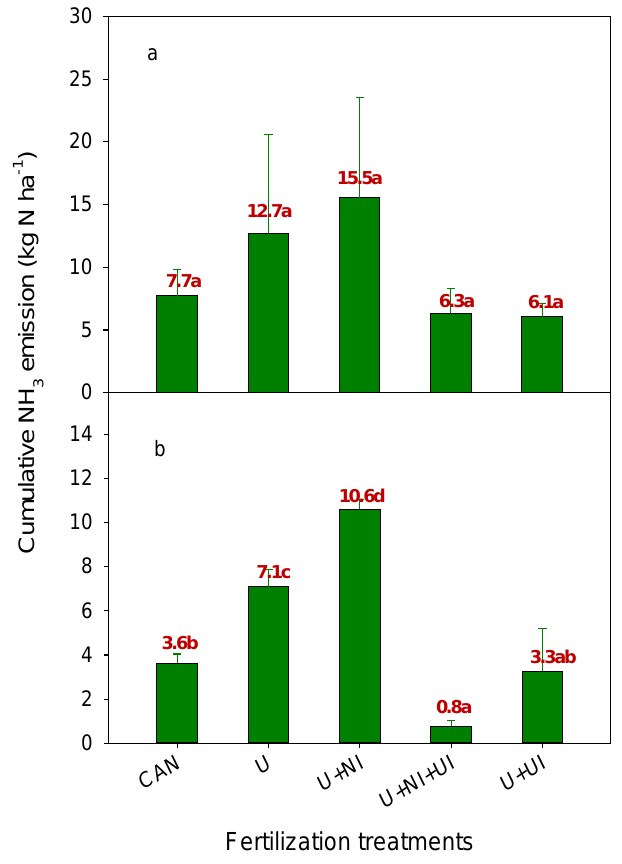
Figure 7. Cumulative NH 3 emissions of di ff erent fertilization treatments (CAN: calcium ammonium nitrate; U: urea; NI: nitrification inhibitor; and UI: urease inhibitor) of winter wheat during 2011 ( a ) and 2013 ( b ). The vertical bars indicate the standard deviation of the mean (n = 3). A mean comparison between fertilization treatments from Tukey´s HSD-test indicates a significant di ff erence at p < 0.05. The same letters indicate groups that were not significantly di ff erent from one